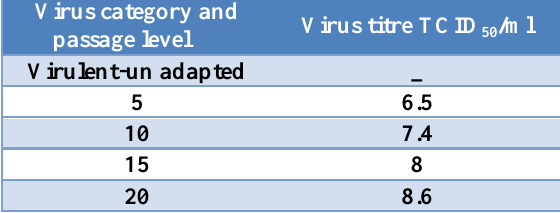
Table,1: Virus titre determined by Tissue Culture Infective Dose